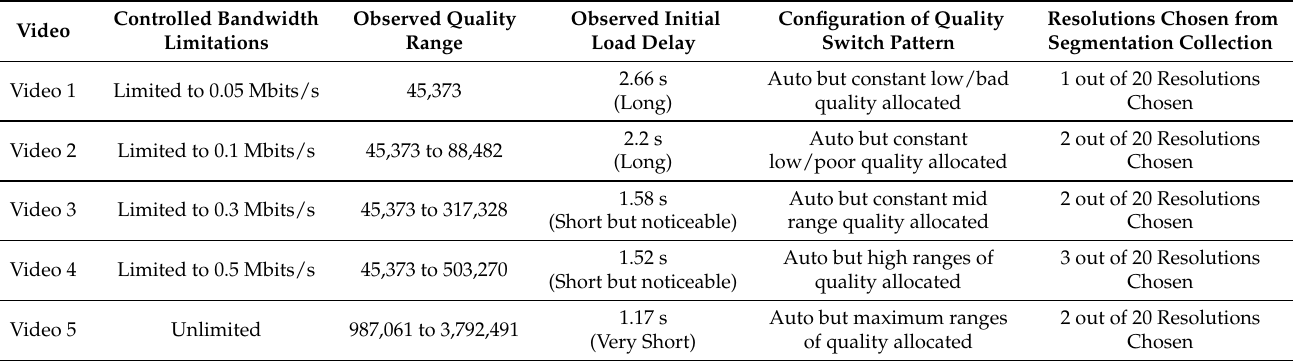
Figure 2. Testbed overview. Table 5. Experimentation video map and test